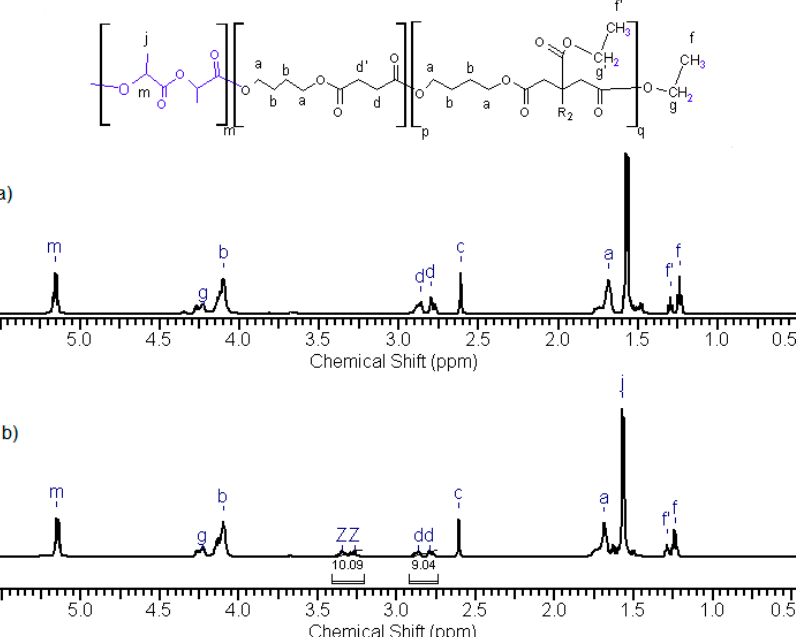
Figure 7. 1 H NMR spectrum of poly( l -lactide)– block –poly(butylene citrate– co –butylene succinate) samples; ( a ) before reaction with trichloracetyl isocyanate and ( b ) after reaction with trichloracetyl isocyanate. Analysis of DSC curves of the obtained copolyesters shows a strong dependence of their composition on the thermal properties. NG 20 copolymer containing 55% mol of lactidyl groups and 29% succinate units, is characterized by the presence of two enthalpies of melting (Table 3), one ◦ associated with ordered lactidyl domains (at 115 C) and second derived from succinate blocks